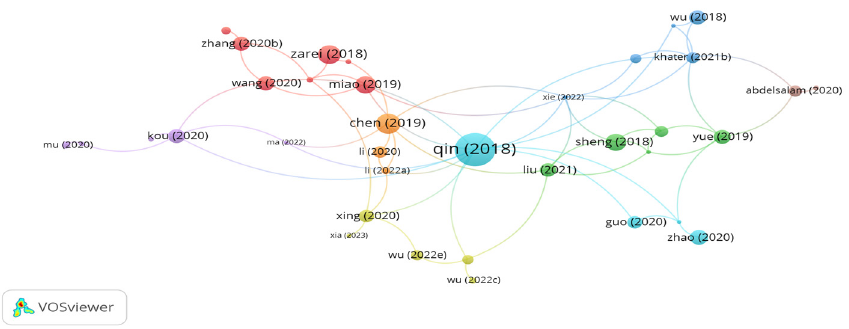
Figure 14. Network visualization of lignin fibers.